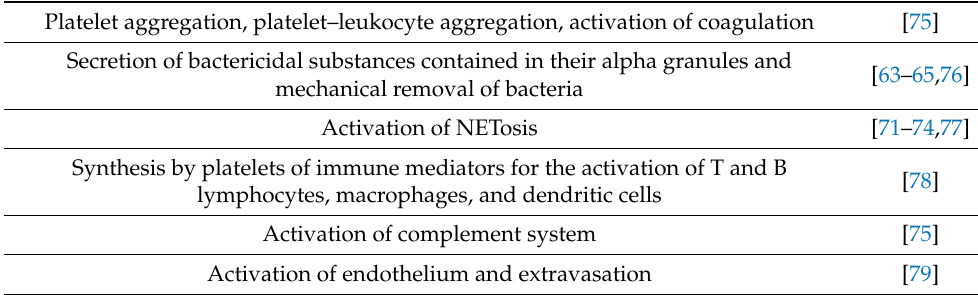
Table 2. Main functions of platelets during IE. Platelet aggregation, platelet–leukocyte aggregation, activation of coagulation [75] Secretion of bactericidal substances contained in their alpha granules and mechanical removal of bacteria Synthesis by platelets of immune mediators for the activation of T and B lymphocytes, macrophages, and dendritic